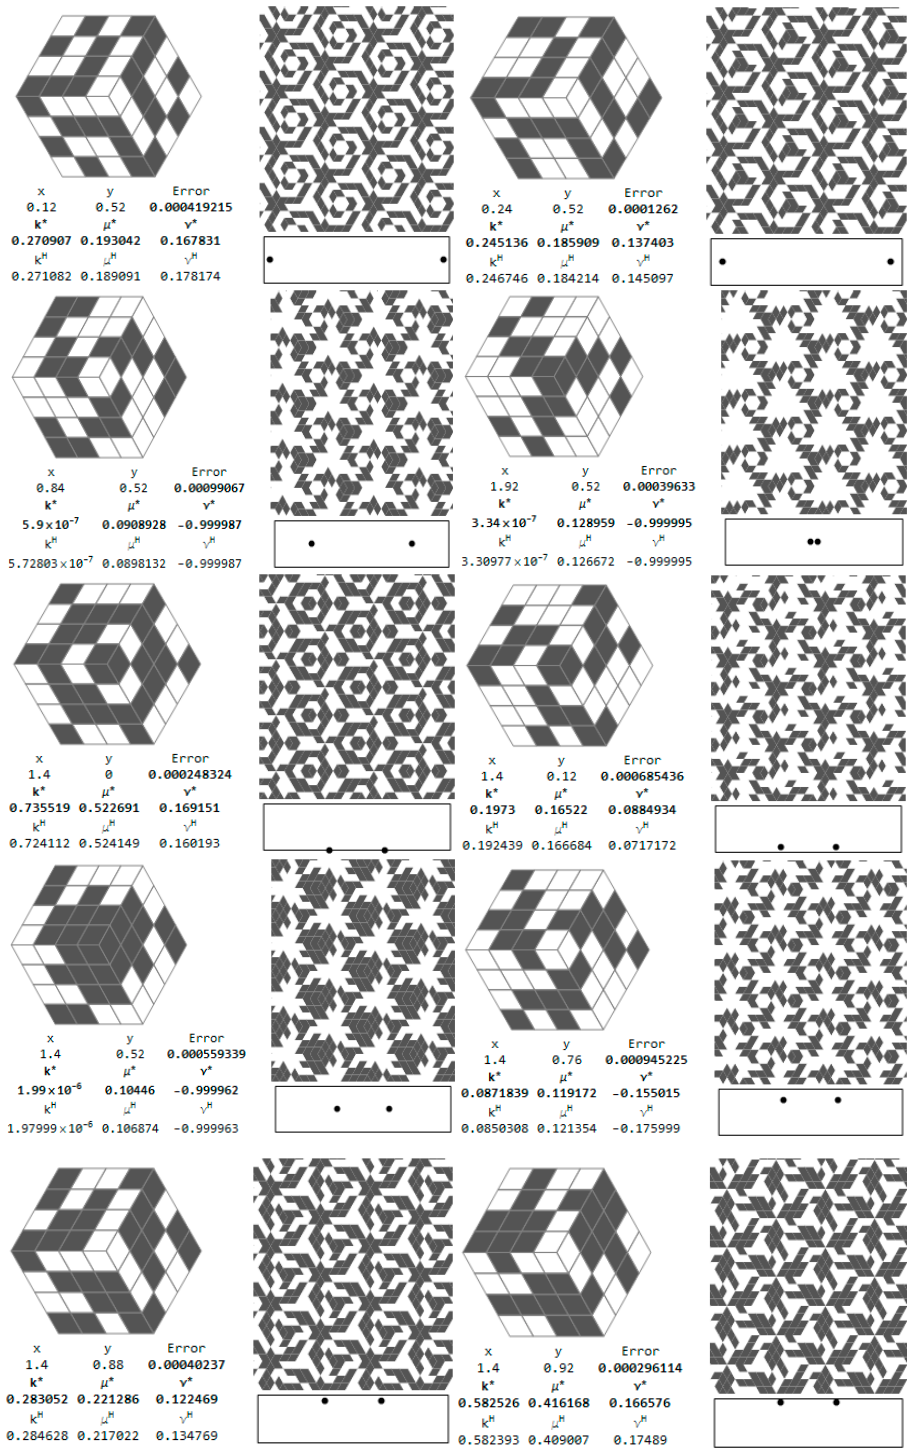
Figure 17. Optimal isotropic microstructures approximating the IMD results with the error (Equation (28)) less than 0.001.